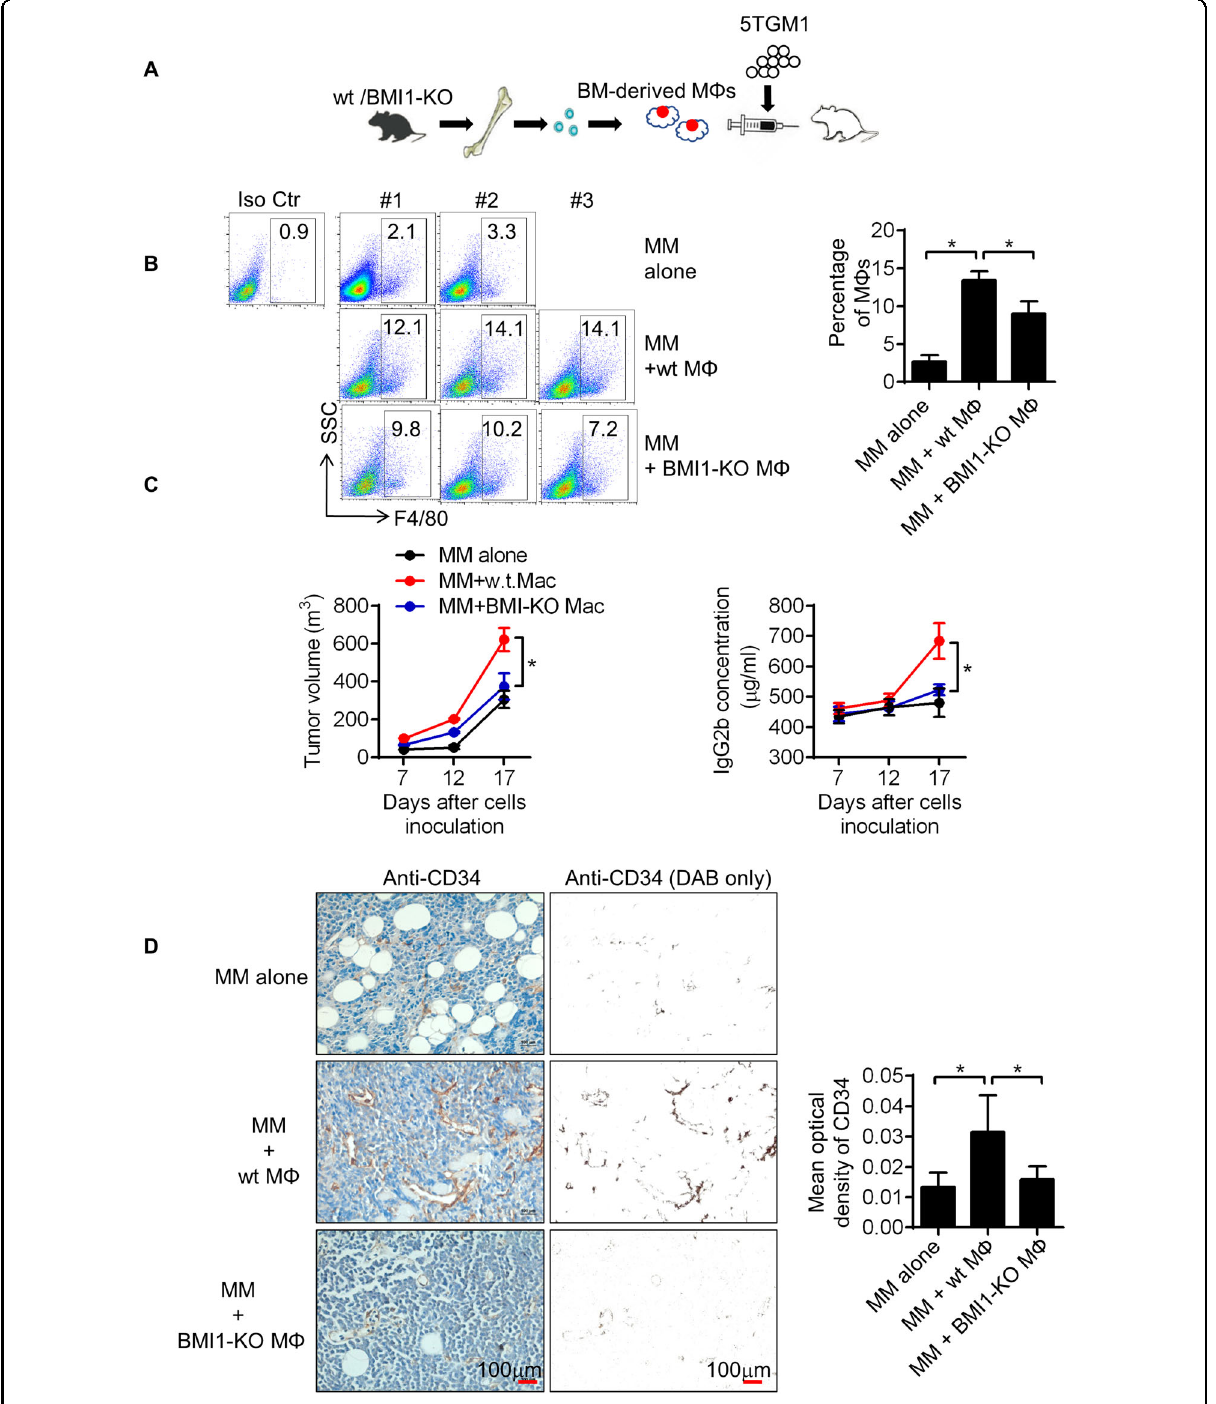
Fig. 7 BMI1 regulates MM-M Φ ’ s pro-myeloma functions in vivo. A Schematic displayed that 5TGM1 cells were injected subcutaneously into the B-NDG mice alone or with BM-derived M Φ s from wt or BMI1-KO mice. B Flow cytometry showed the proportion of M Φ s in the subcutaneous tumor beds 7 days after inoculation (Left panel). Tumors with wt M Φ s had the most M Φ s in tumor beds (right column). Statistical signi fi cance was determined by two-tailed Student t -test between tumors with 5TGM1 alone and with wt MM-M Ф s, or between tumors with wt and BMI1-KO MM-M Ф s, * P < 0.05. C Left panel showed the growth curves of 5TGM1 xenografts, wt M Φ s were the most potent in promoting tumor growth. Right panel showed monoclonal protein IgG2b concentrations in murine peripheral blood, mice bearing tumors with wt M Φ s had the highest concentrations of IgG2b. Statistical signi fi cance was determined by two-tailed Student t -test between groups with wt and BMI1-KO MM-M Ф s, * P < 0.05. D Representative IHC staining images (left images) and quanti fi cation of positive cells (right column) of epithelial cell marker CD34. Statistical signi fi cance was determined by two-tailed Student t -test between tumors with 5TGM1 alone and with wt MM-M Ф s, or between tumors with wt and BMI1-KO MM-M Ф s, * P < 0.05. Of fi cial journal of the Cell Death Differentiation